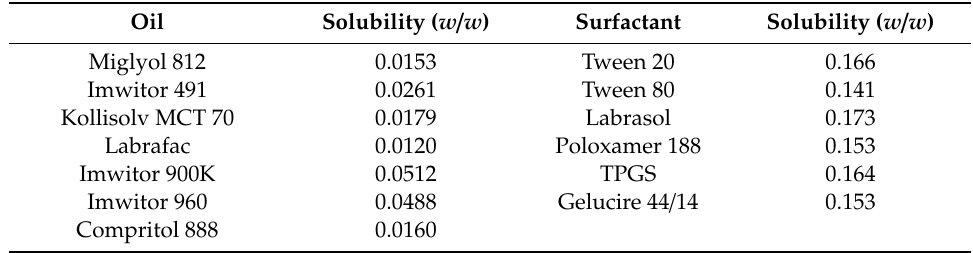
Table 1. Solubility of curcumin in oils and surfactants.